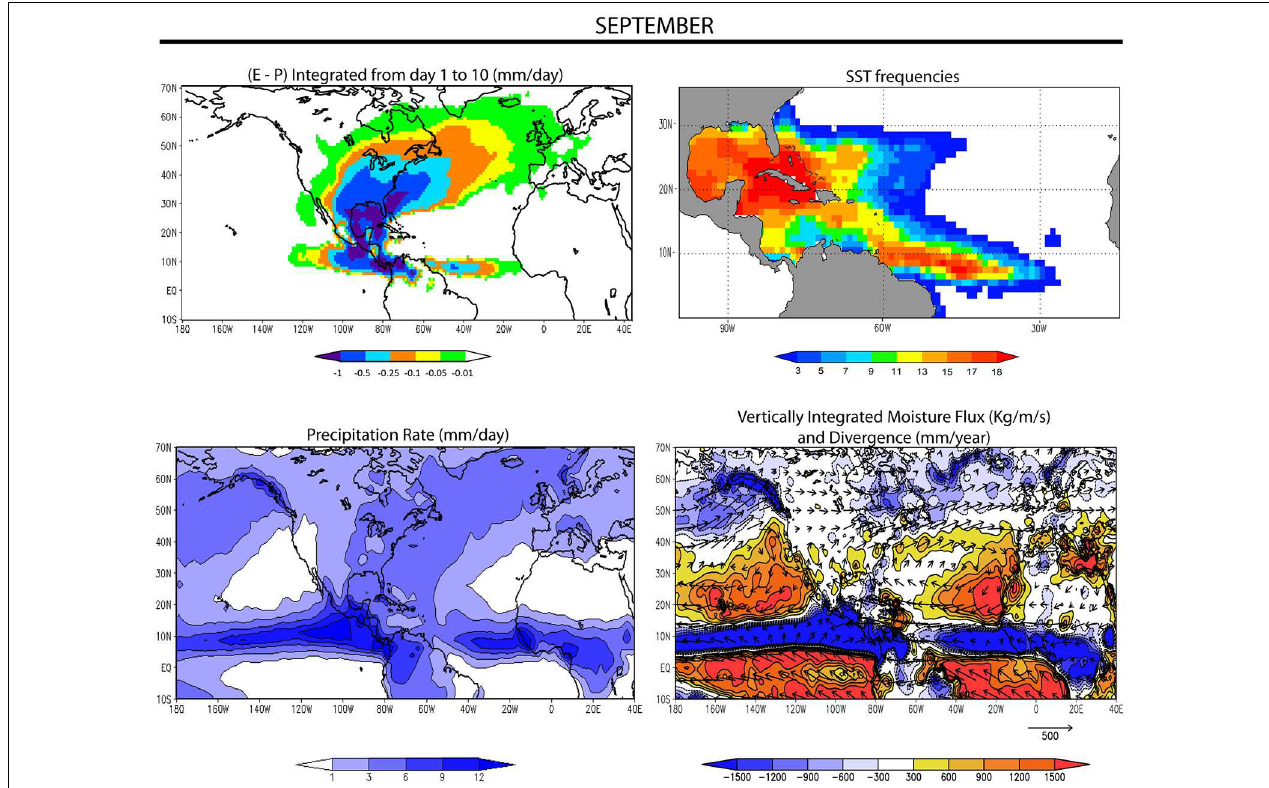
FIGURE 5 | As Figure 1, for